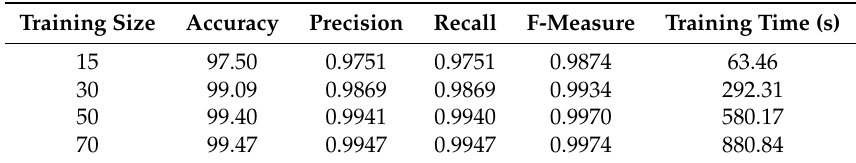
Table 3. Performance results depending on training